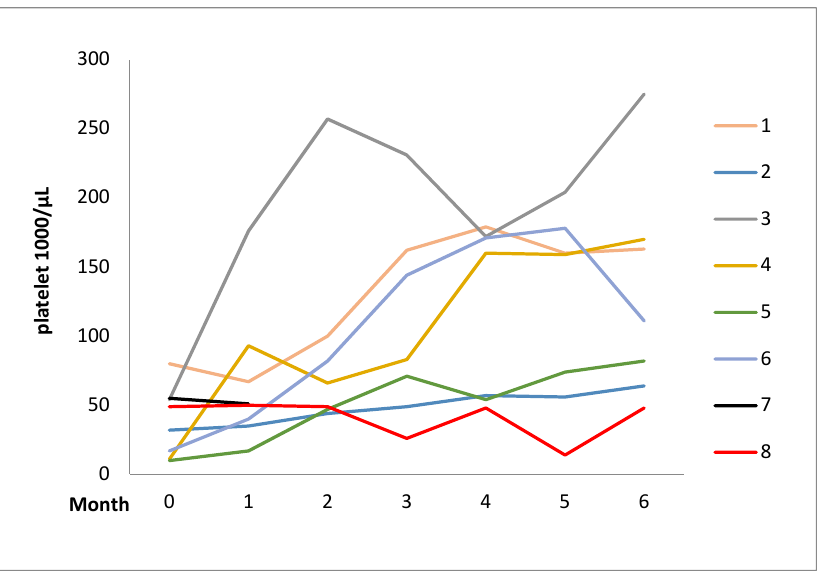
Figure 2. Serial changes in platelet levels over time in immune thrombocytopenia after the initiation of danazol.